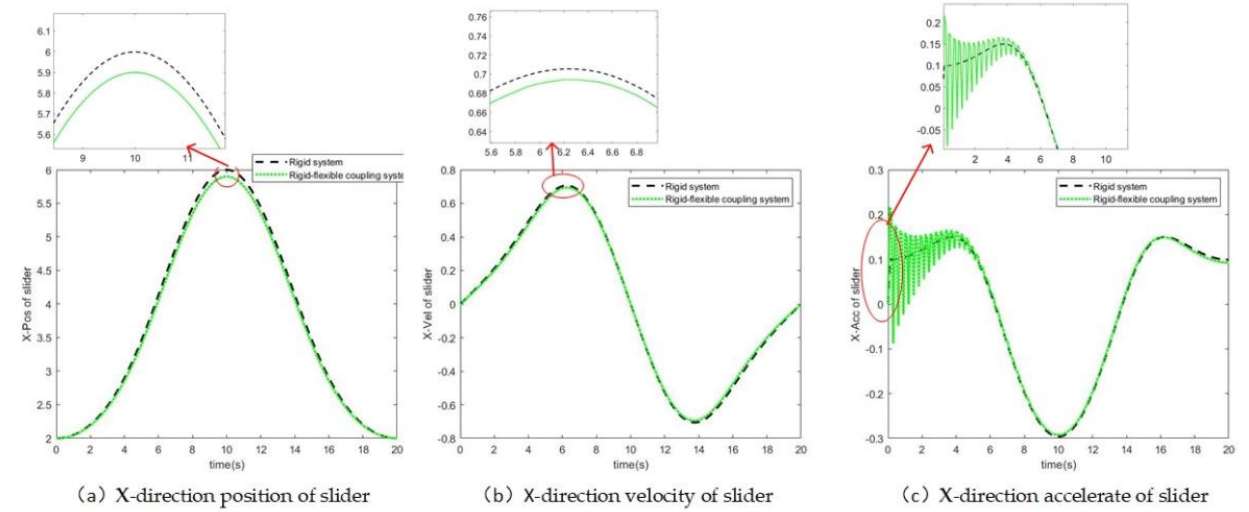
Figure 6. Comparison of kinematic parameters of slider in X direction.